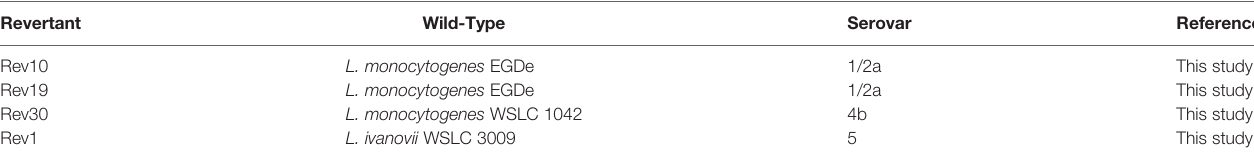
TABLE 1 | Revertant strains used in this